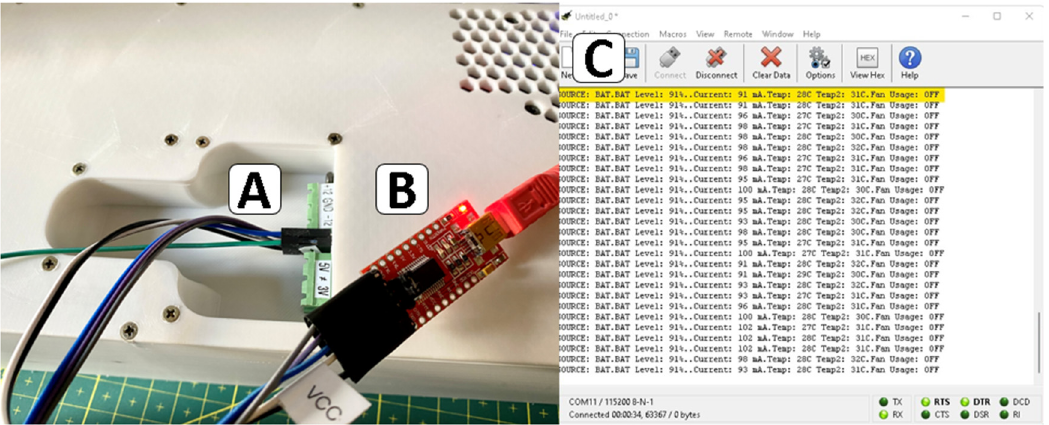
Figure 23. Serial Communication test setup: A—Power supply UART communication port, B—UART-USB converter, C—CoolTerm user interface.